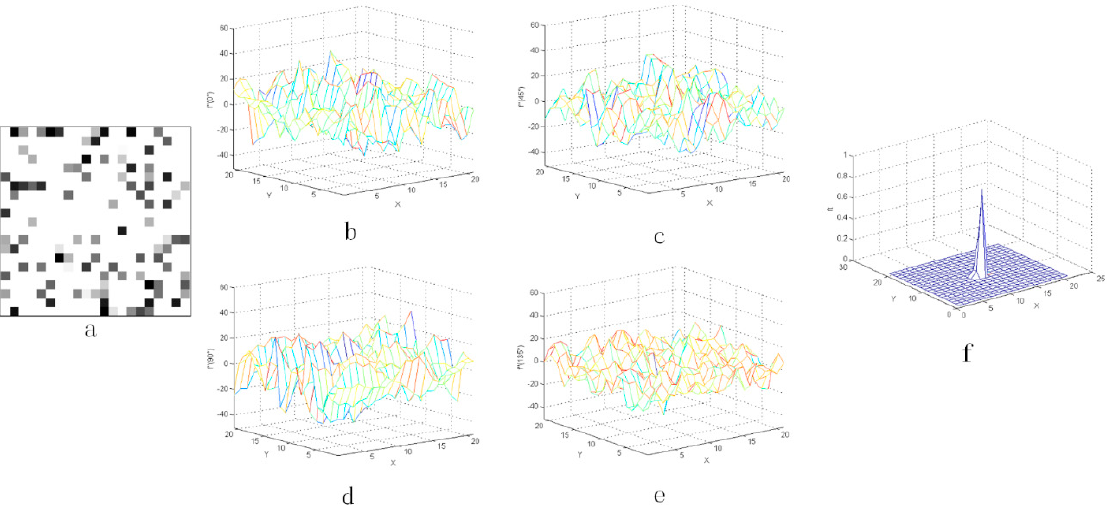
Figure 11. The result with the noise whose coefficient Q is 50%: ( a ) the star image with added random noise and ( b – e ) the three-dimensional distribution of the second-order derivative, ( f ) the output value f t after CMLCM processing.